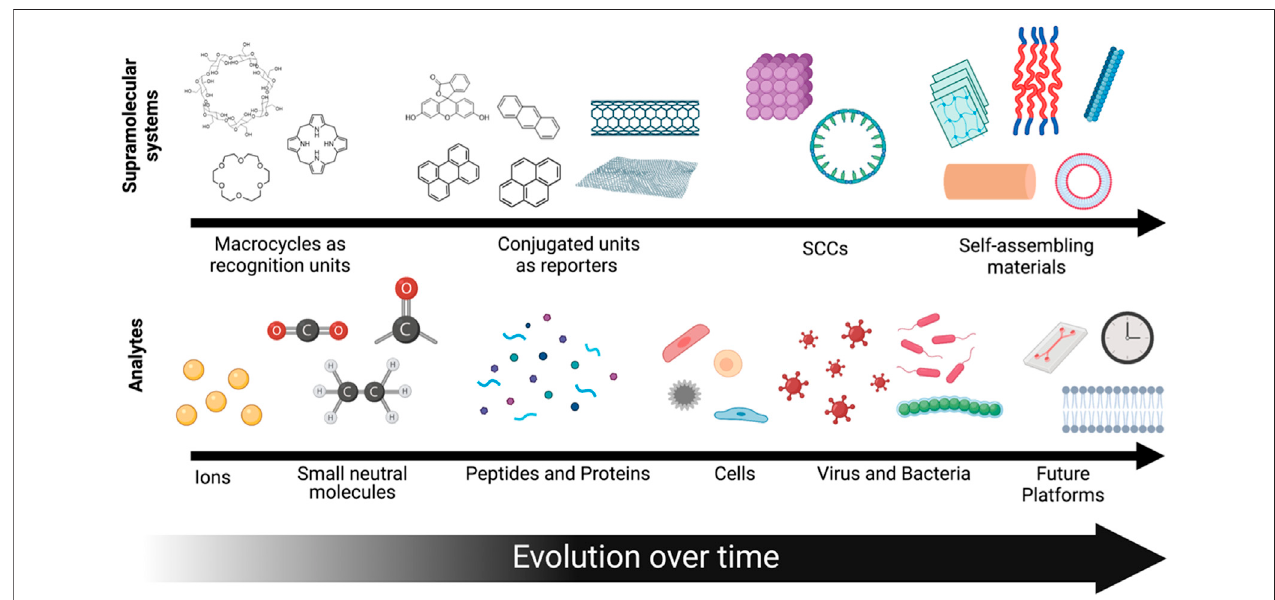
FIGURE 11 | A schematic depiction of the evolution of supramolecular systems developed over time and the analytes that they can detect.